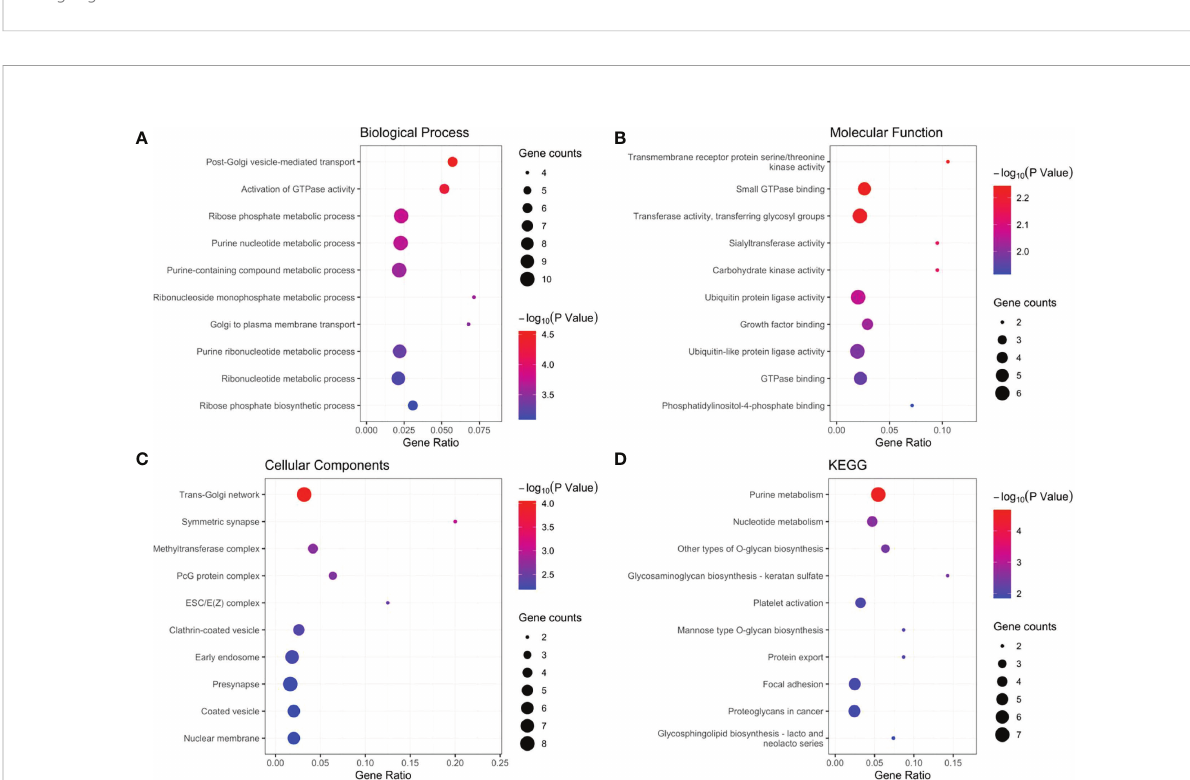
FIGURE 5 Target genes of cell senescence-related lncRNAs.